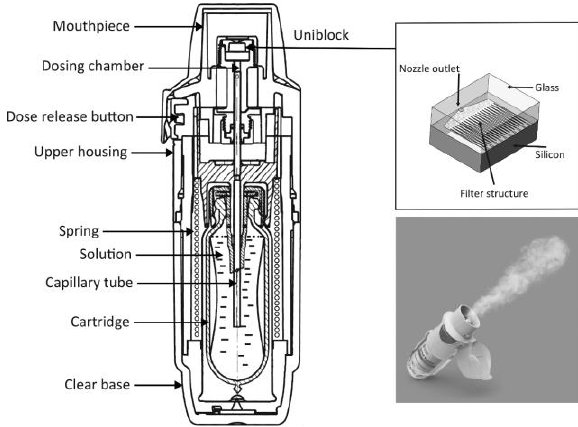
Fig. 1: Scheme of Respimat SMI [12]